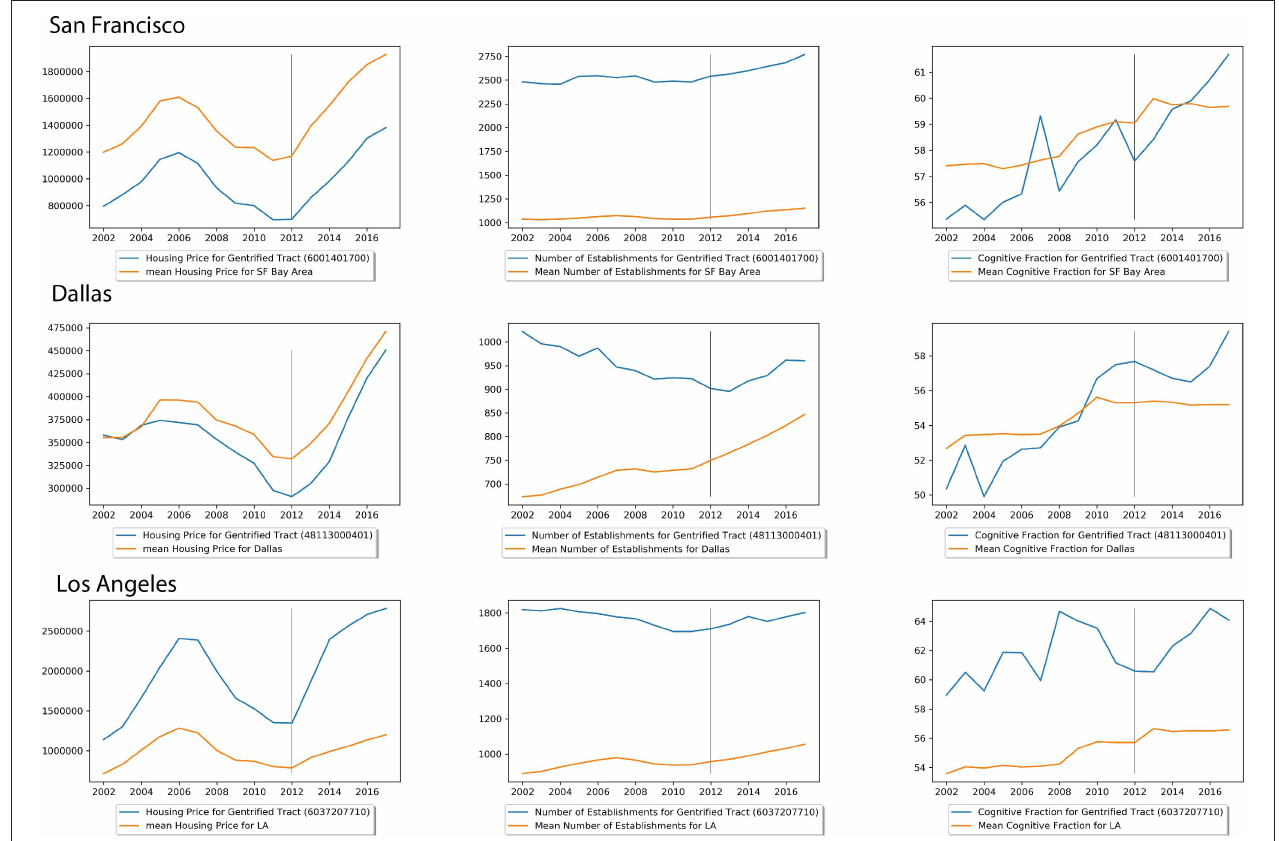
FIGURE 5 | Temporal change in variables of tracts defined by National Community Reinvestment Coalition (NCRC) as gentrified tracts in 2012.